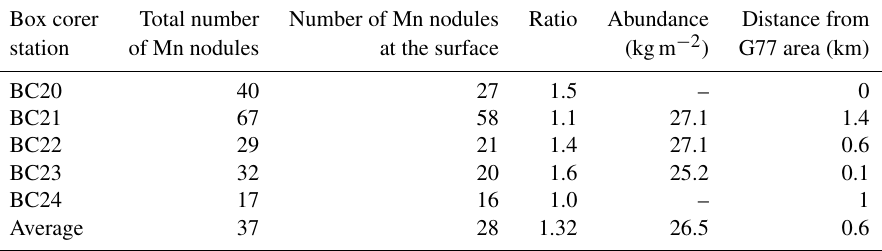
Table 2. The number of Mn nodules on the sediment surface, the total number of Mn nodules per box core, the ratio of those two values, and the distance of the box corer deployments from the study area in block G77. Box corer Total number Number of Mn nodules Ratio Abundance Distance from station of Mn nodules at the surface (kgm − 2 ) BC20